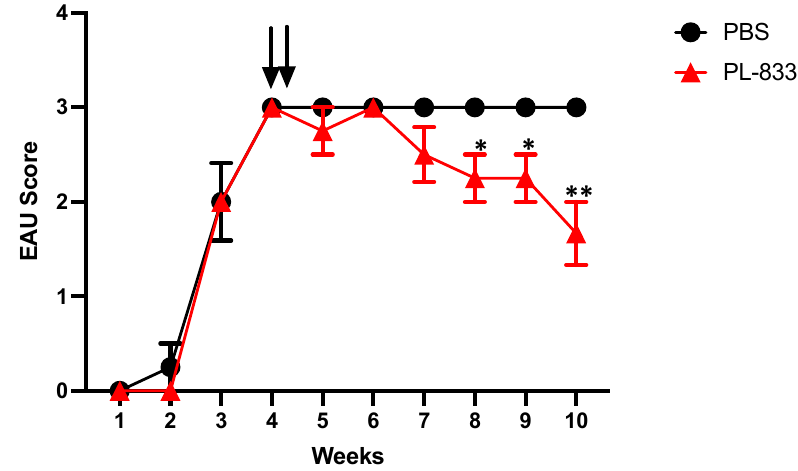
Figure 1. Effects of treating EAU mice with PL-8331. Mice were immunized to induce EAU, and the retinas were examined by microscopy and scored. The mice were treated with PL-8331 on week 4, as indicated by the arrows. Presented are the mean ± SEM of the EAU scores of each treated group over the weeks after immunization to induce EAU. Statistical differences of EAU clinical scores from PBS (vehicle)-treated EAU mice are indicated, * p ≤ 0.05, ** p ≤ 0.01; N = 4. All other values were not statistically different between groups.